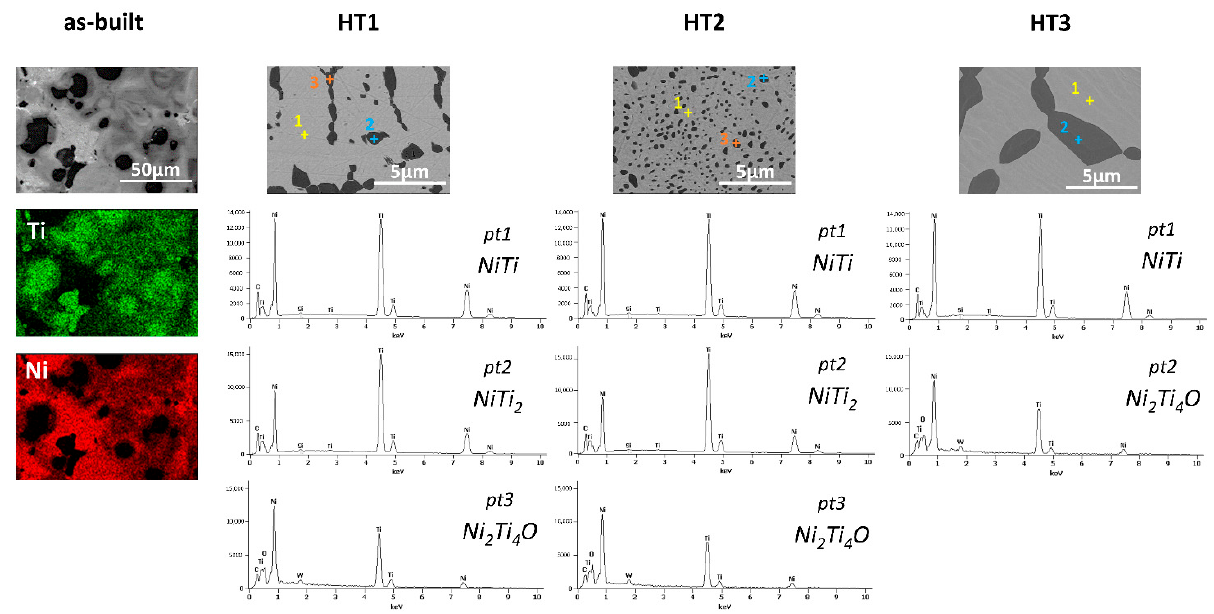
Figure 5. EDS mapping of the as-built sample indicates that the dark shaded areas are titanium-rich and bright shaded areas are nickel-rich; EDS point analysis revealed the presence of Ni, Ti, and O elements. Table 2. The volume fraction of NiTi 2 /Ni 2 Ti 4 O phases in HT1-HT3